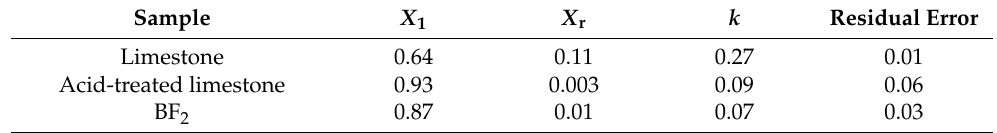
Figure 2. Cumulative energy storage density in 50 repeated cycles. Table 2. Fitting parameters for multicyclic energy storage according to Equation (3). Sample